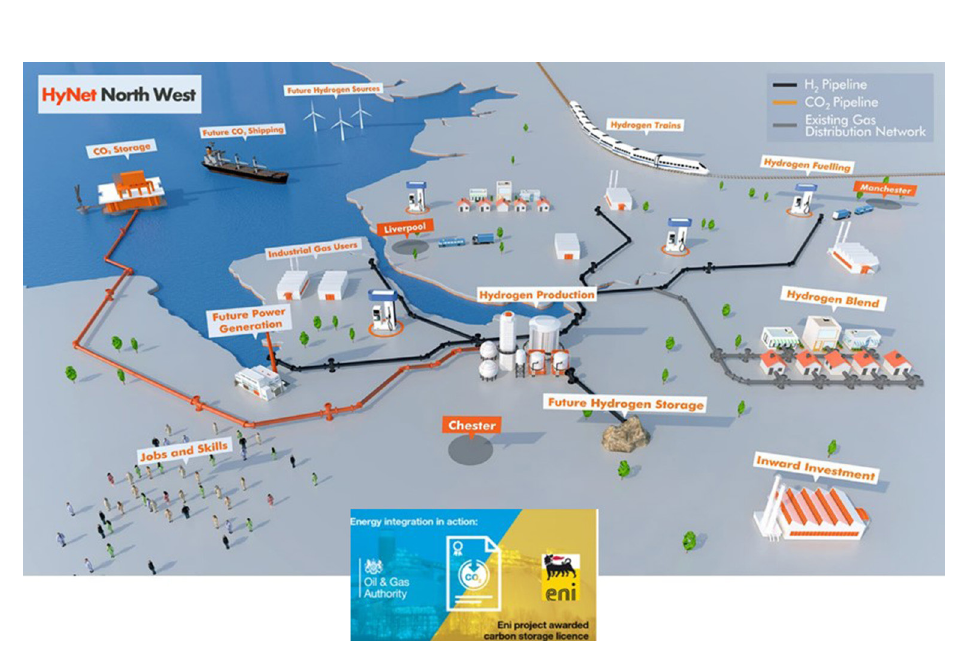
Fig. 25. – Overview of the HyNet project (Eni operator): decarbonisation of refineries, fertiliser and cement plants, H 2 production with Autothermal Reforming (ATR) in Northern